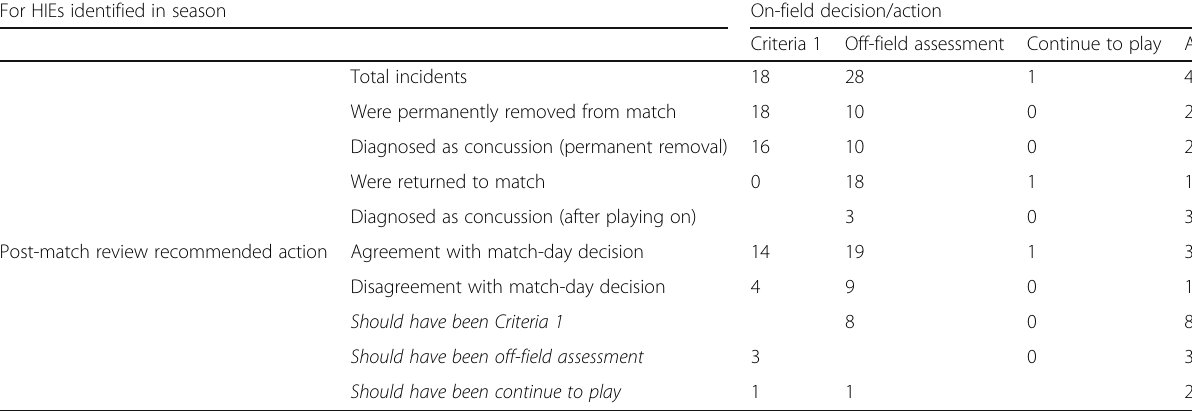
Table 1 Overview of match-day review decisions For HIEs identified in